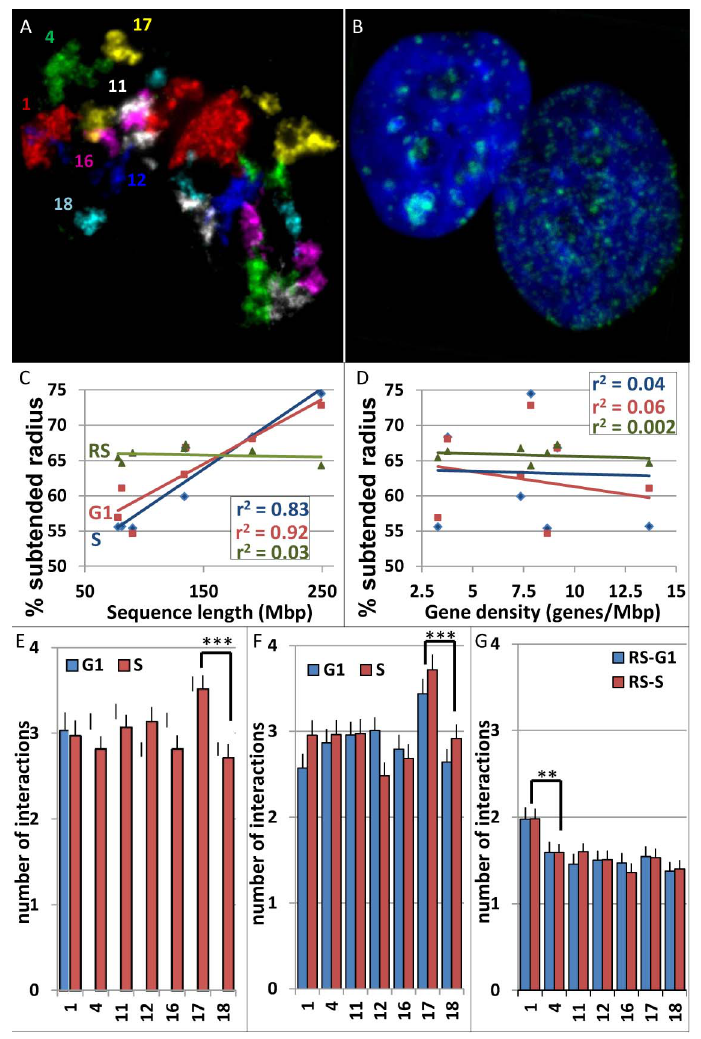
Figure 1. Multi-FISH labeling, radial positioning, and total interactions of CT during the cell cycle. 2-D projection images of: ( A ) 7 CT (1,4,11,12, 16,17,18) and ( B ) EdU labeled replication sites and DAPI staining in 10A cells. ( C–D ) Radial positioning- The percent subtended radii (the distance from the center of the nucleus to the CT center divided by the distance from the center of the nucleus through the CT center to the nuclear periphery in 10A cells) is displayed against chromosome sequence length ( C ) and gene density ( D ). Blue is G1, red is S, and green is random simulations. ( E–F ) Total pairwise CT interactions- The average number of CT within the subset of CT that each individual CT interacts with is shown for WI38 ( E ), 10A ( F ), and random simulations ( G ). Blue is G1 and red is S. All experimental values were significant higher than random simulations. CT17 interacts with a significantly greater number of CT than any other CT in the subset. CT1 is significantly higher than the other CT in random simulations. ***p ,